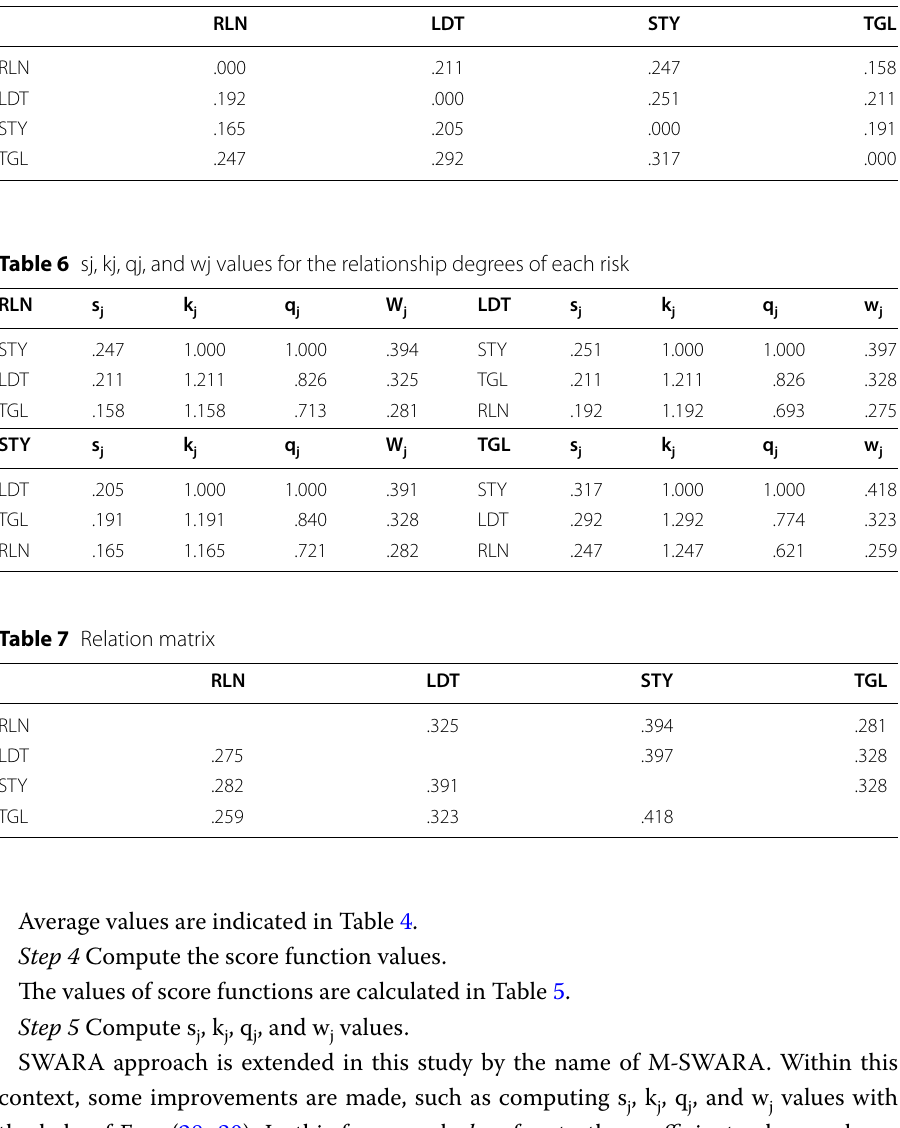
Table 5 Score function values of the risks